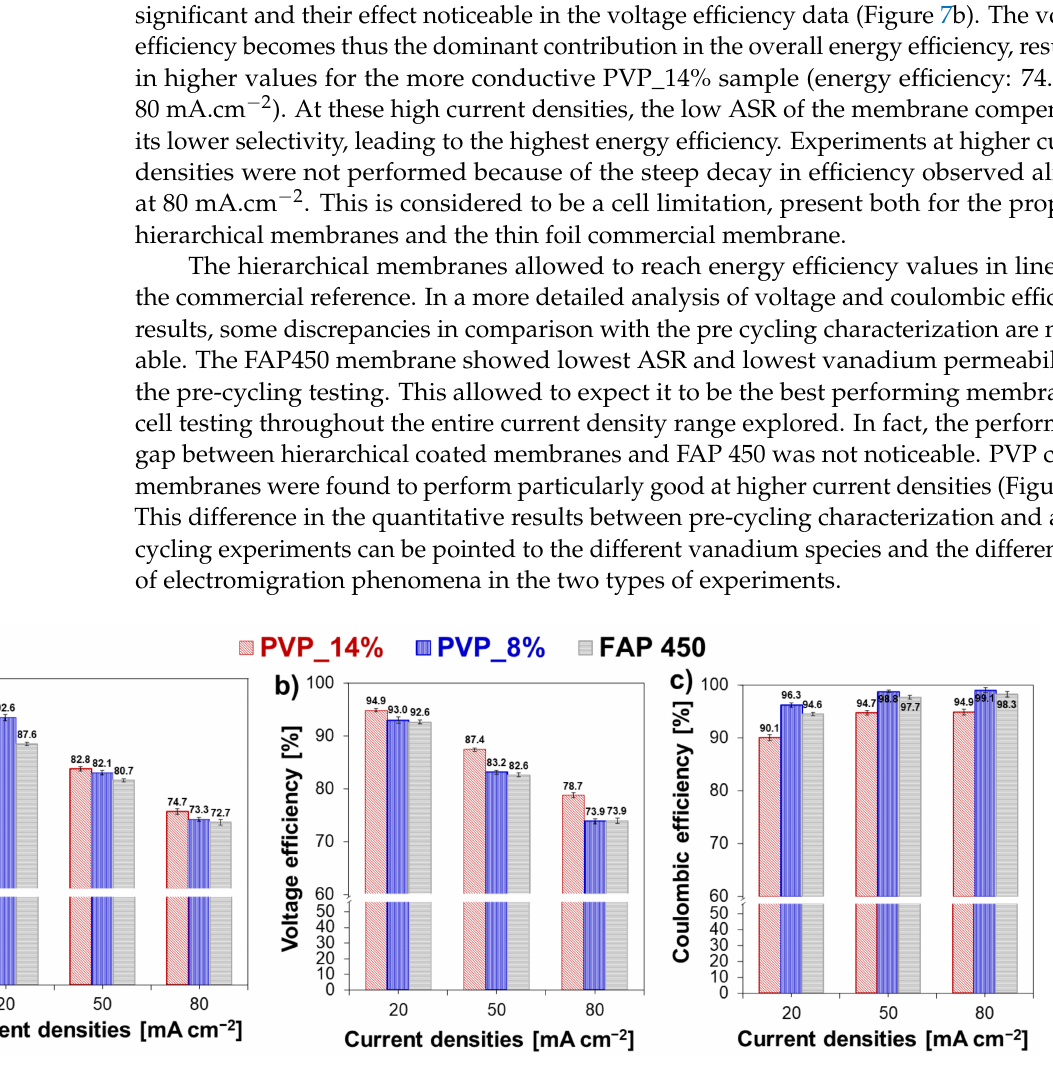
Figure 7. Energy ( a ), voltage ( b ) and coulombic efficiency ( c ) of the VRFB single cell assembled with FAP 450 and the fabricated hierarchical membranes prepared with 8 and 14 w / w % of PVP at different current